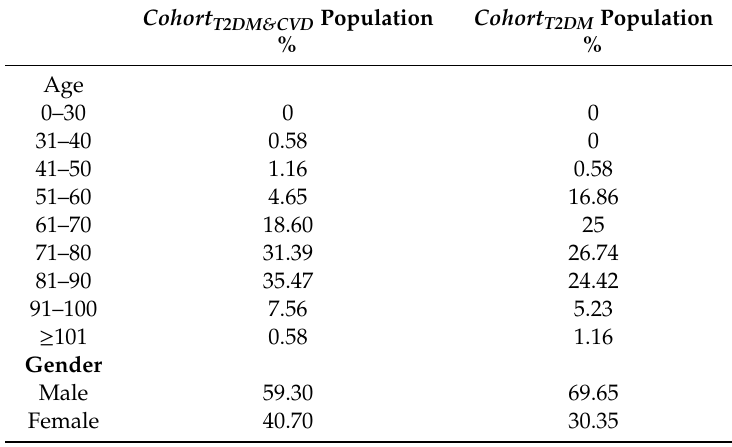
Table 8. Age and sex distribution of the population for both Cohort T2DM&CVD and Cohort T2DM . Cohort T2DM&CVD Population Cohort T2DM %